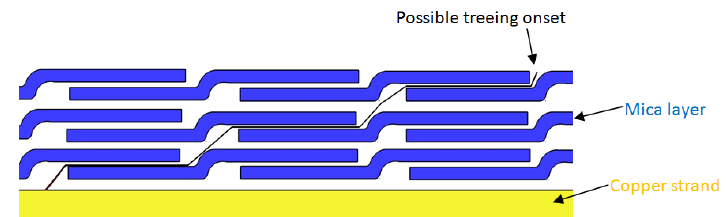
Figure 17. When the mica-layers are wrapped around the coil, it remains a possible path for a treeing. Even if the path is elongated by the half-overlapped mica layers, this will lead to a breakdown of the insulation